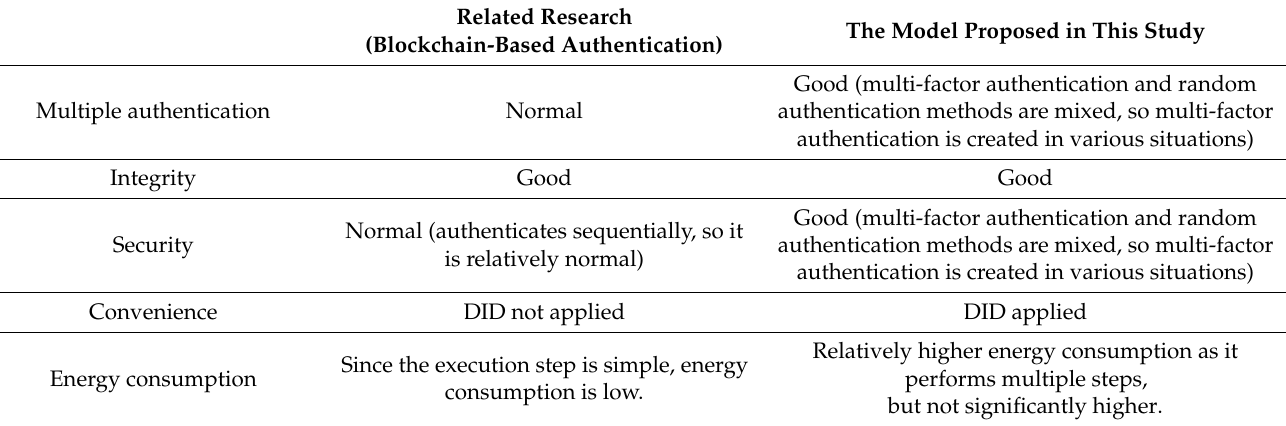
Table 1. Comparison of related research and this